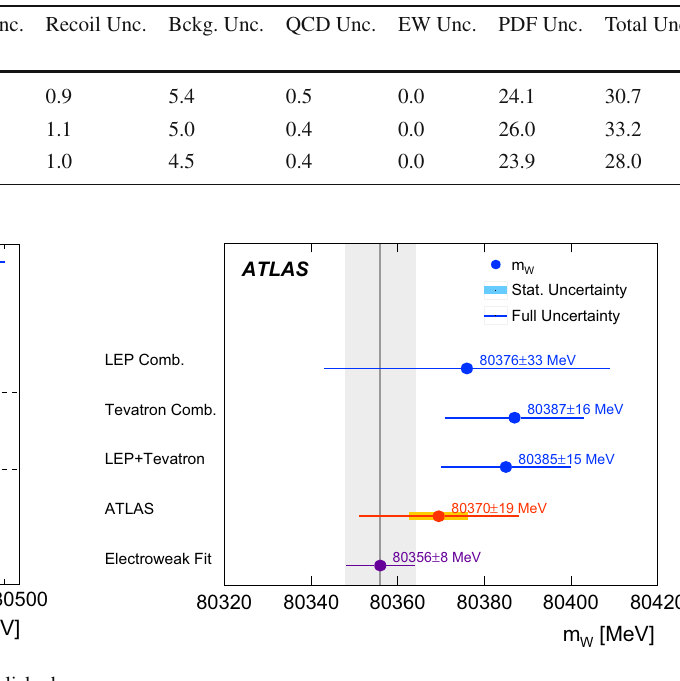
Fig. 29 The present measurement of m W is compared to the SM pre- diction from the global electroweak fit [16] updated using recent mea- surements of the top-quark and Higgs-boson masses, m t = 172 . 84 ± 0 . 70 GeV [122] and m H = 125 . 09 ± 0 . 24GeV [123], and to the com- bined values of m W measured at LEP [124] and at the Tevatron col- lider [24] the muon channel has four | η (cid:7) | bins and eight categories in total. The fully combined result